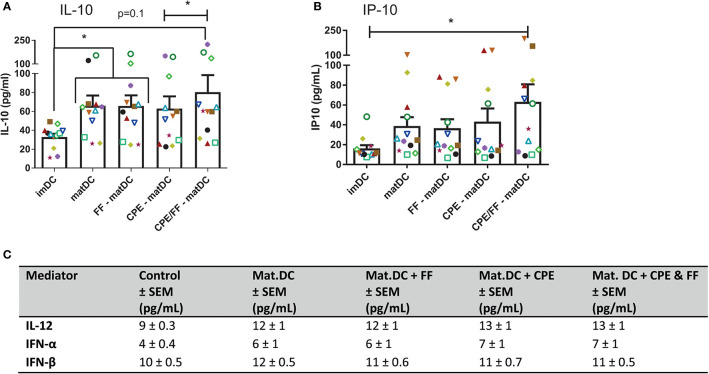
Cytokine production by DCs. After maturation, supernatant of DCs was harvested and analyzed by luminex. IL-10 produced by DCs increased when DCs were exposed to the maturation mix (A). Although CPE and scFOS/lcFOS (FF) did not further enhance IL-10, the combination of CPE and FF increased IL-10 concentrations compared to CPE alone. IP-10 production by DCs increased after combined maturation with CPE and FF (B). No effects of maturation, CPE and FF were observed for IL-12, IFN-α, and IFN-β (C). Data are presented as mean ± SEM, *P<0.05, n=12. The different symbols and colors represent the measured values of independent peanut allergic donors.